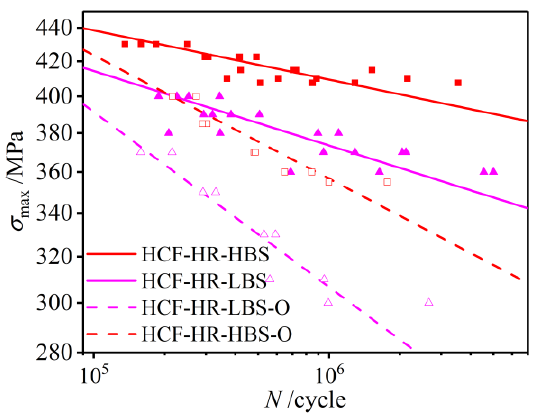
Figure 9. Comparison of the fatigue S-N curves for TC bimetallic steel with various interfacial con- ditions.